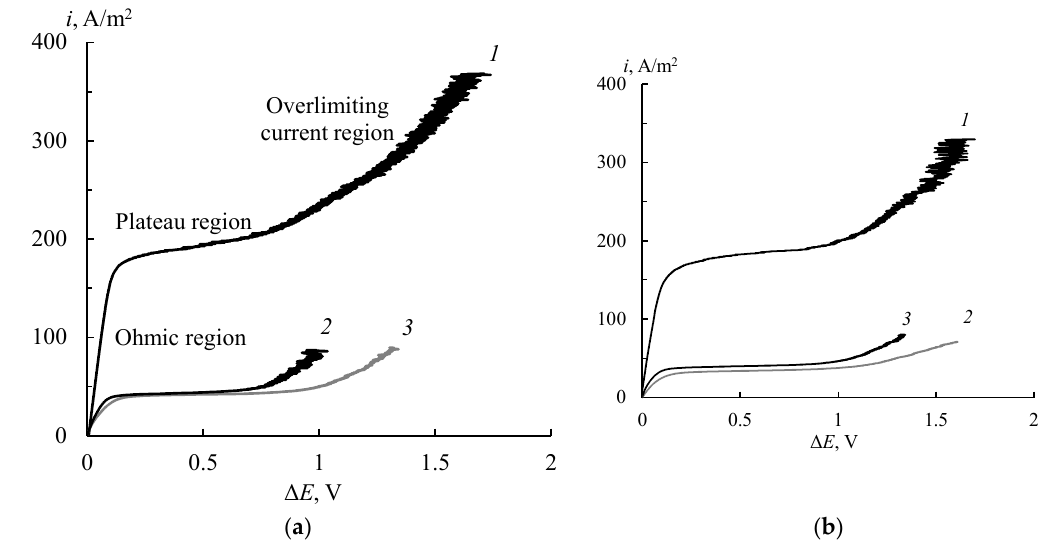
Figure 6. CVCs of the initial MF-4SK ( a ) and MK-40 ( b ) membranes in 0.05 mol-eq/L solutions of HCl (1), NaCl (2) and CaCl 2 (3).